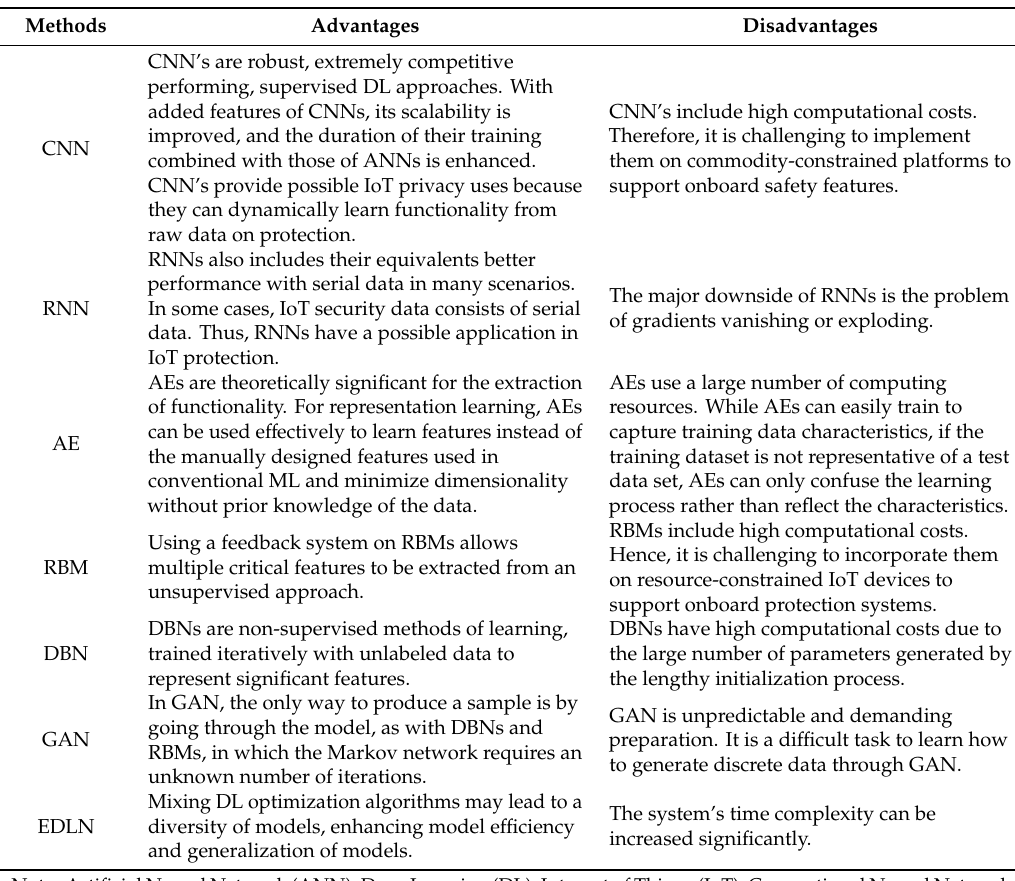
Table 3. The common advantages and disadvantages of deep learning (A portion of the Table is adapted with permission from [134], 2020, IEEE).